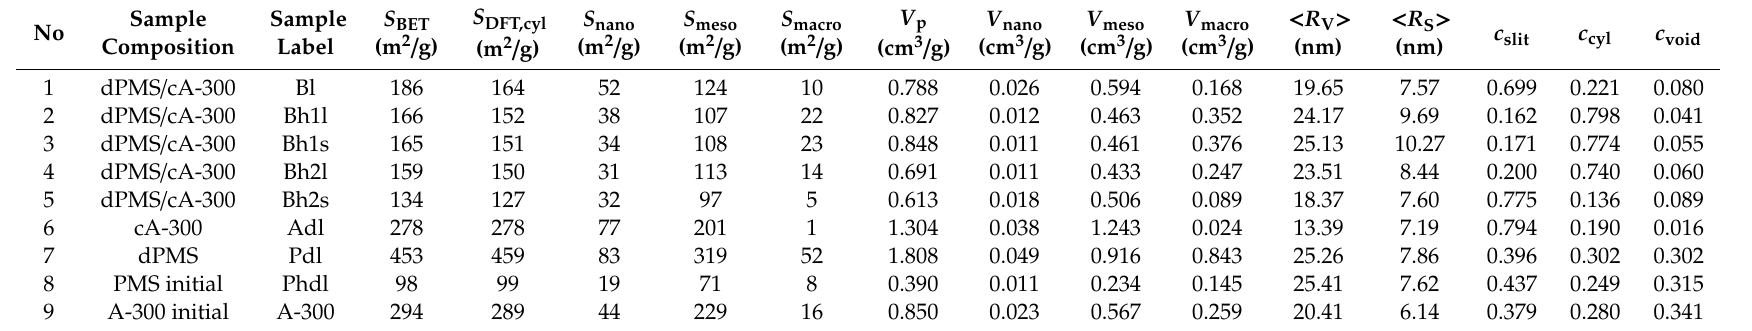
Table 1. Textural characteristics of PMS, A-300, and their blends (SCV / SCR